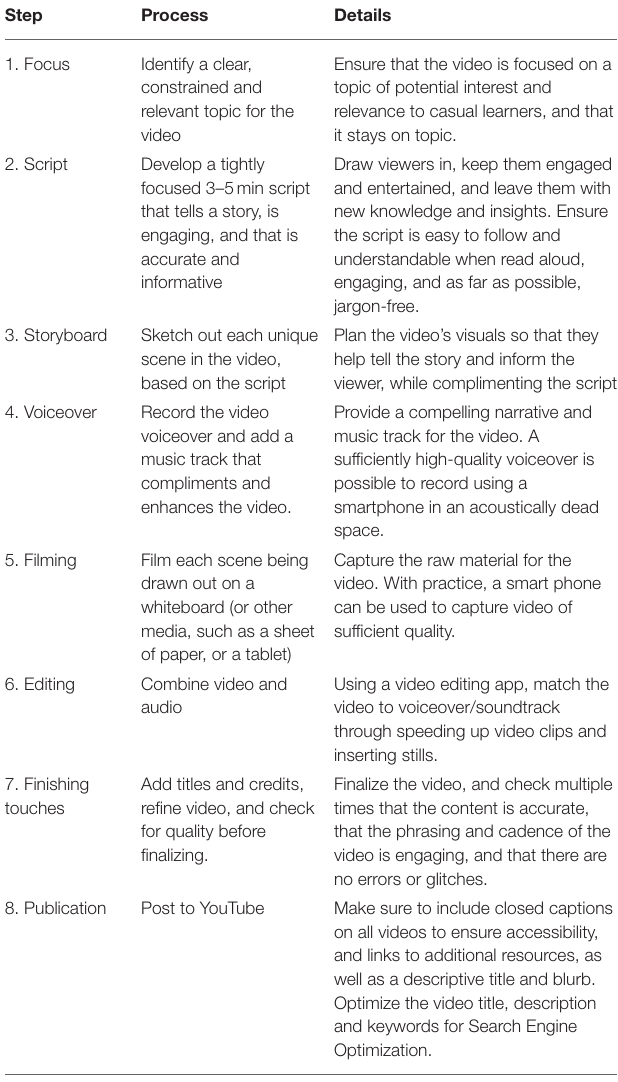
TABLE 1 | Workflow followed for Risk Bites from the initial idea to the final video a